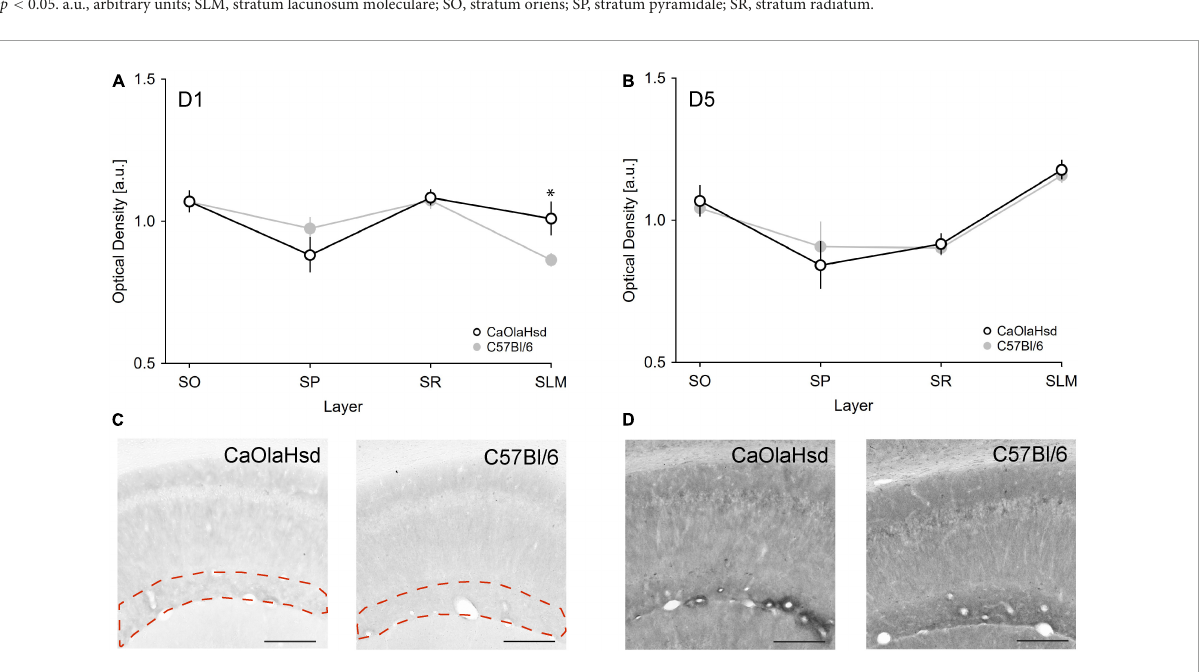
FIGURE5 Expression of D1 and D5 receptors are different in CaOlaHsd and C57Bl/6 mice. (A,B) The graphs depict the optical density of D1R (A) and D5R (B) expression in different layers of CA1 in CaOlaHsd (open black circles) and C57Bl/6 (closed gray circles) mice. D1 receptor expression is significantly higher in CaOlaHsd mice compared to C57Bl/6 mice in SLM (A) . The CA1 sublayers assessed show no differences with regard to D5 receptor expression in CaOlaHsd mice compared to C57Bl/6 mice (B) . SLM: stratum lacunosum moleculare, SO: stratum oriens, SP: stratum pyramidale, SR: stratum radiatum. (C,D) Immunostainings of the different layers in the CA1 region of CaOlaHsd and C57Bl/6 mice. The dotted magenta lines in (C) outline the stratum lacunosum moleculare, where D1R (C) showed increased expression in CaOlaHsd mice. No